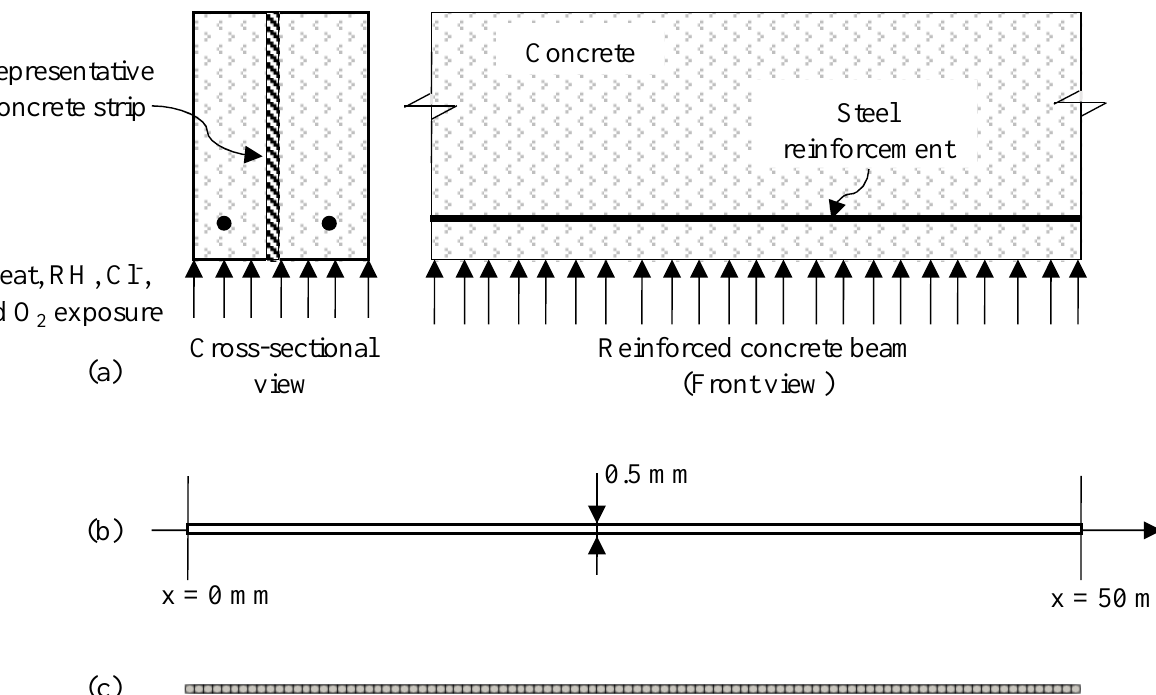
Figure 4. ( a ) Representative concrete strip for 1-D transport in RC beam problem; ( b ) concrete strip model; ( c ) meshing of the concrete strip.